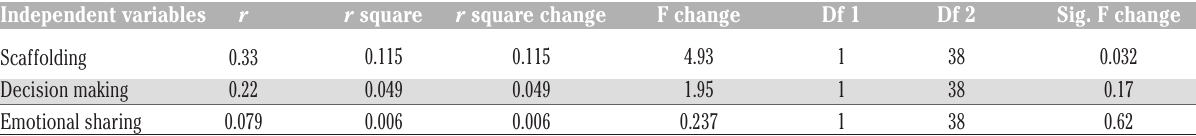
Table 7. Regressions for the TMA ( test multidimensionale dell'autostima ) environmental mastery scale. Independent variables r r square